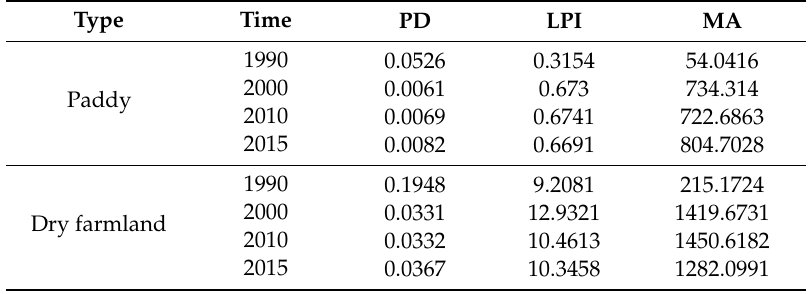
Table 2. The indices (PD, LPI and MA) applied to describe the patch features of paddy and dry farmland. Type